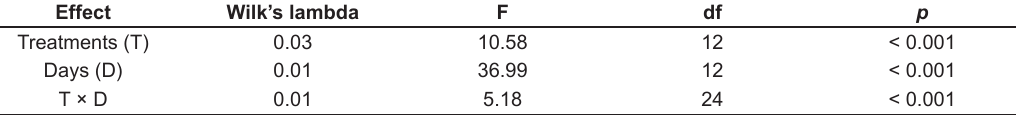
Table 3. Results of factorial MANOVA testing the effects of treatments (mesotrophic, eutrophic and hypereutrophic), experiment days (days 1, 7 and 14) and their interaction term on the density of zooplankton species ( Moina minuta , Latonopsis sp., Brachionus urceolaris , Hexarthra mira and Thermocyclops sp.) and nauplii pooled together.